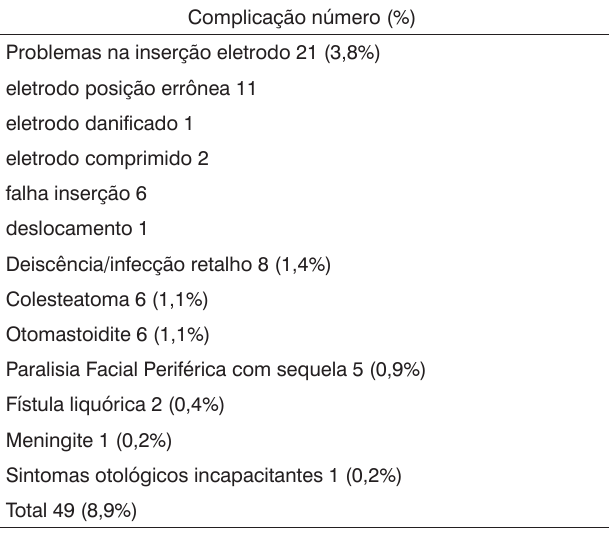
Tabela 1. Complicações